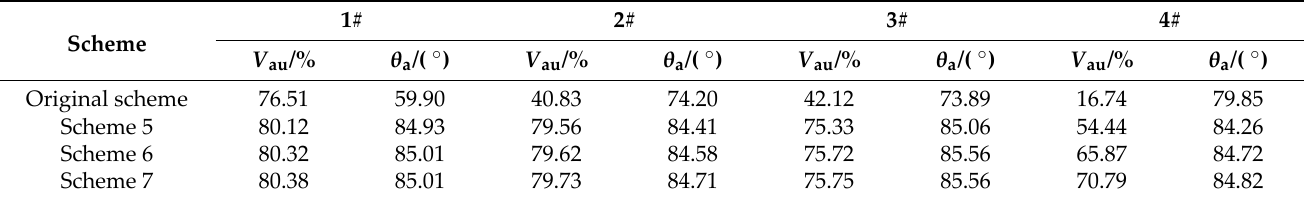
Table 5. Axial velocity uniformity and axial velocity weighted average angle of Section 4 for each